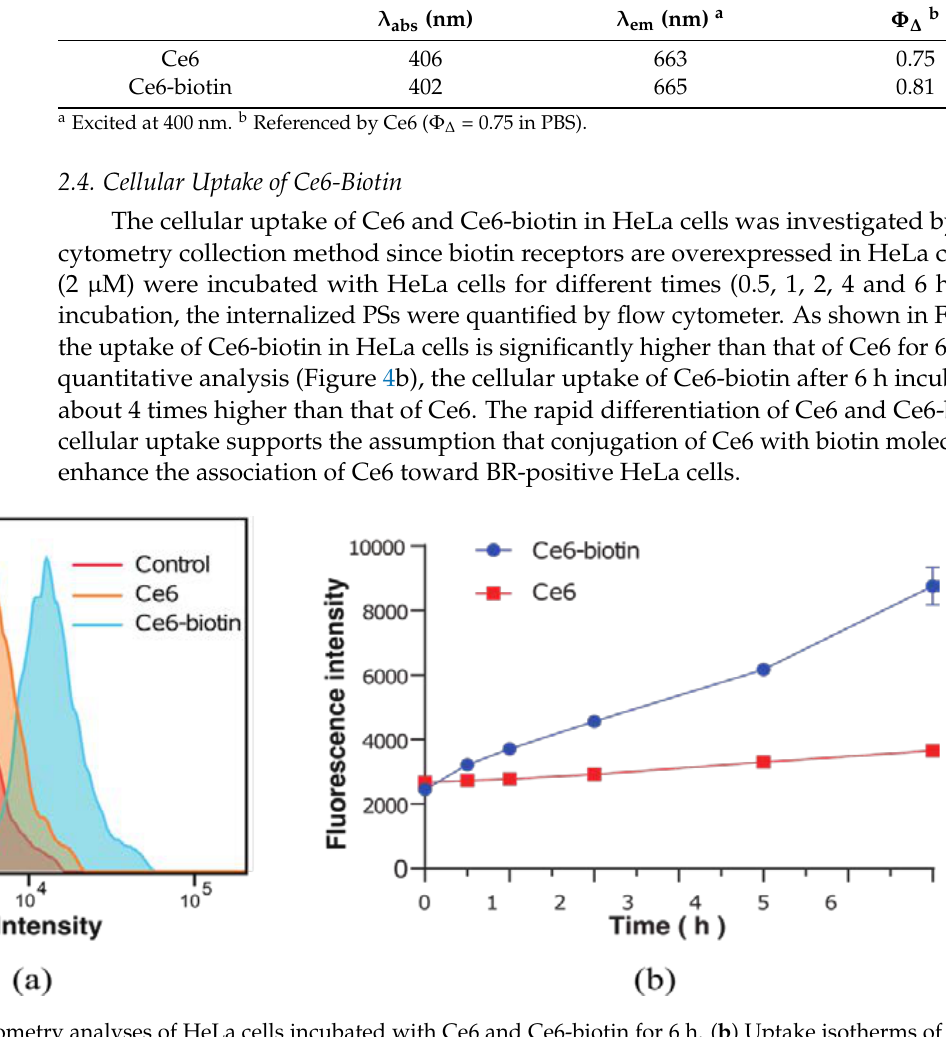
Figure 5. Confocal fluorescence images of HeLa cells without incubation with photosensitizers ( a ) and after incubation with Ce6 ( b ) and Ce6-biotin ( c ). Scale bars: 20 µm. 2.5. Therapeutic Efficacy and Dark Cytotoxicity of Ce6-biotin In order to measure the therapeutic efficacy and dark cytotoxicity of Ce6 and Ce6- biotin, the 3-(4,5-dimethylthiazol-2-yl)-2,5-diphe-yltetrazolium bromide (MTT) assay was used to determine the viability of the cells treated with the two PSs. The cells treated at zero concentration were set as control groups. Without irradiation, Ce6 and Ce6-biotin